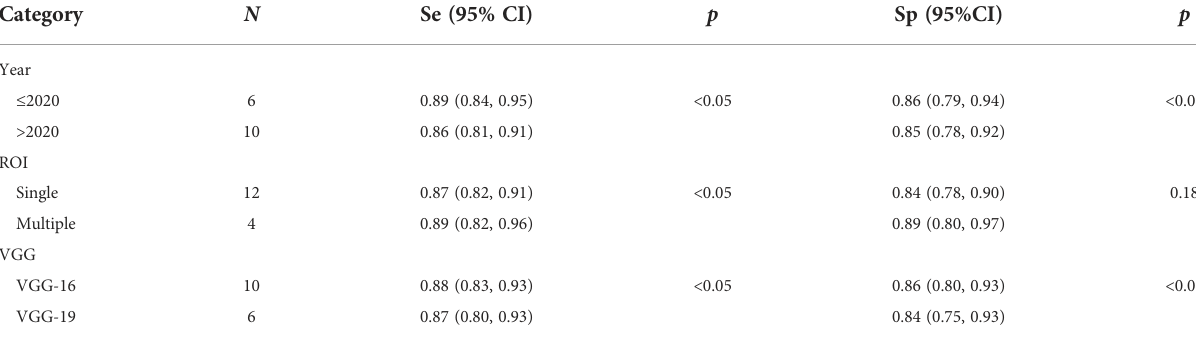
TABLE 2 Meta-regression of ultrasound-based deep learning for differentiating and diagnosing benign and malignant of thyroid nodules. Category